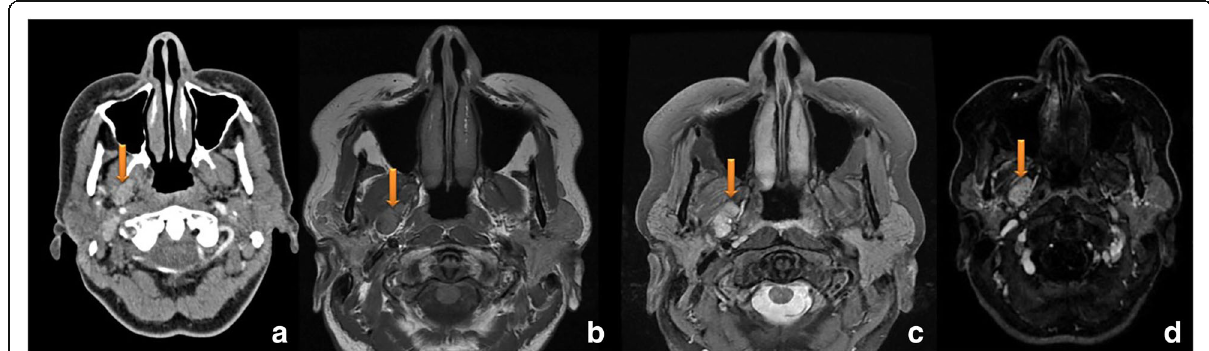
Fig. 9 SFT of the parapharyngeal space. Axial CT after administration of intravenous contrast medium demonstrates a small homogeneous soft tissue mass with lobular borders in the right parapharyngeal space. Axial T1-weighted ( b ), T2- weighted ( c ) and gadolinium-enhanced T1-